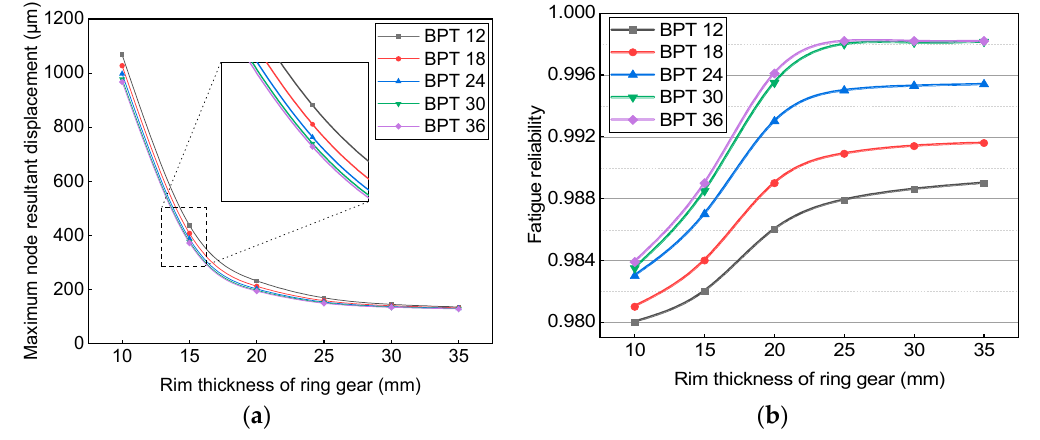
Figure 19. Elastic deformation and reliability results: ( a ) elastic deformation curves of the ring gear. ( b ) System reliability growth curves. Notes: BPT is the base plate thickness of the planet carrier.